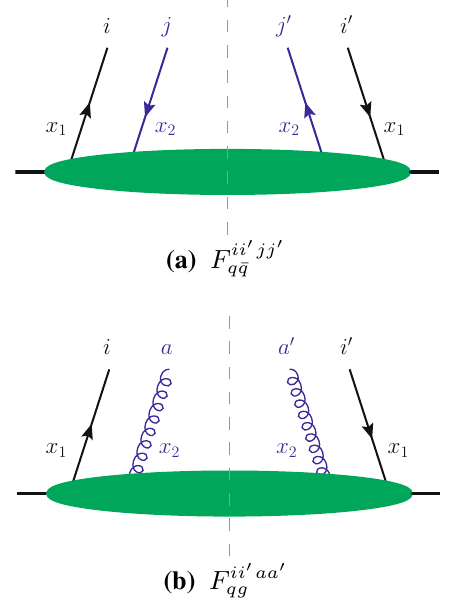
Fig. 1 Assignment of colour labels for a quark–antiquark distribution ( a )andaquark–gluondistribution( b ).Thedashedverticallineindicates the final state cut of the scattering process in which the distributions